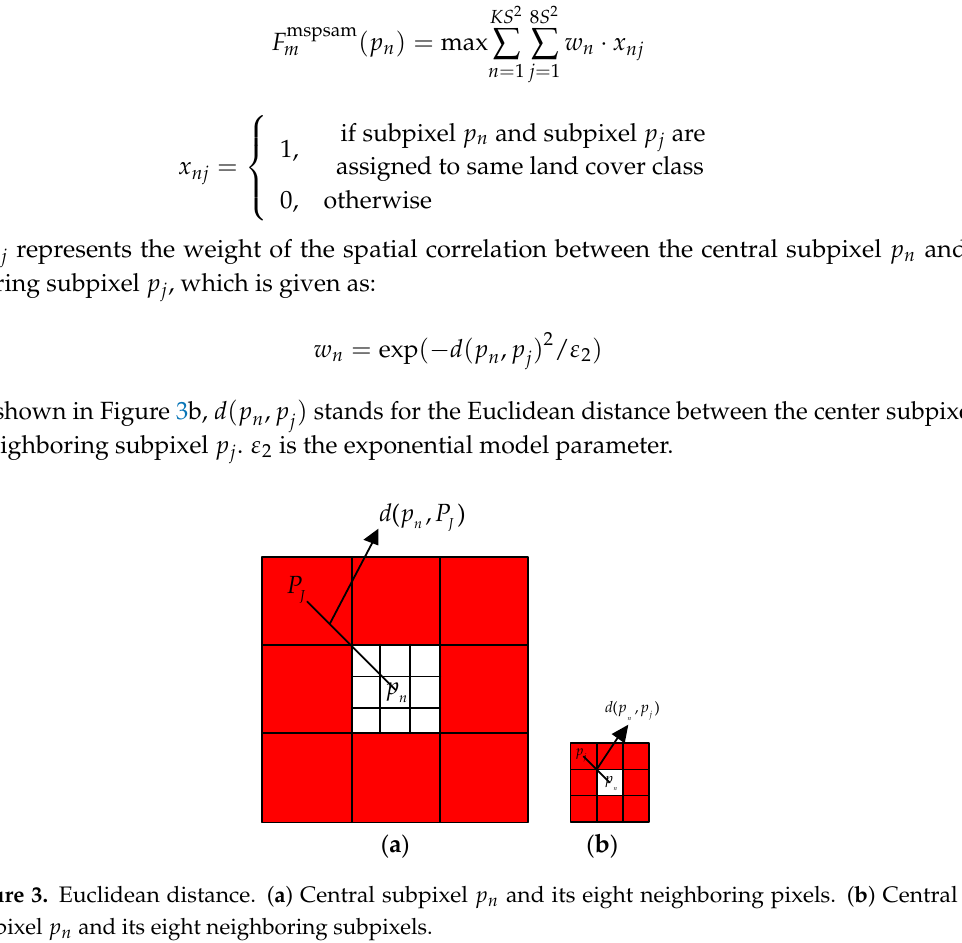
Figure 3. Euclidean distance. ( a ) Central subpixel p n and its eight neighboring pixels. ( b ) Central subpixel p n and its eight neighboring subpixels.